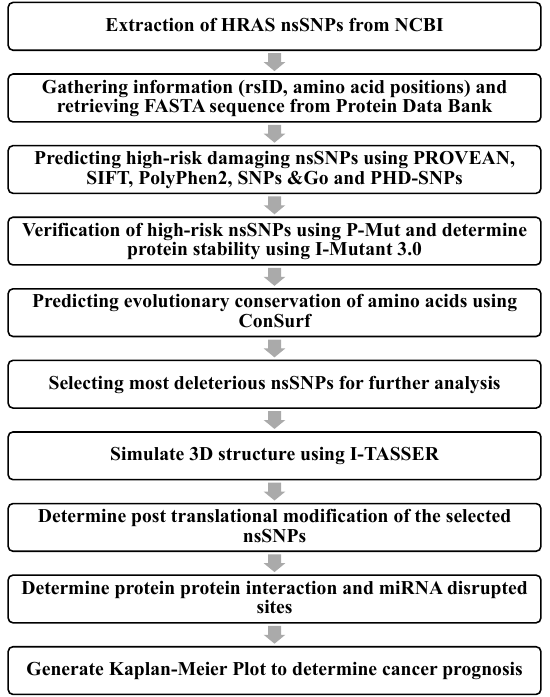
Figure 1. Flow chart of bioinformatics steps in this study.